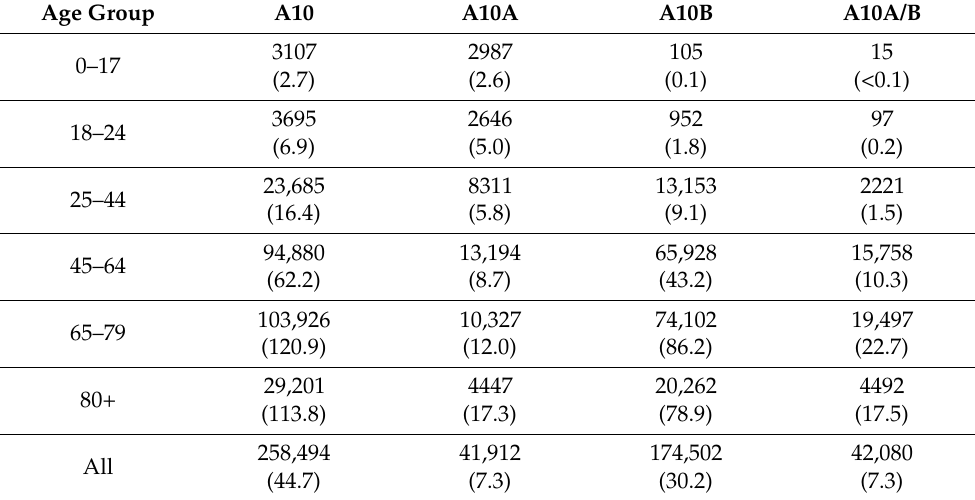
Table 1. Consumption of drugs used in